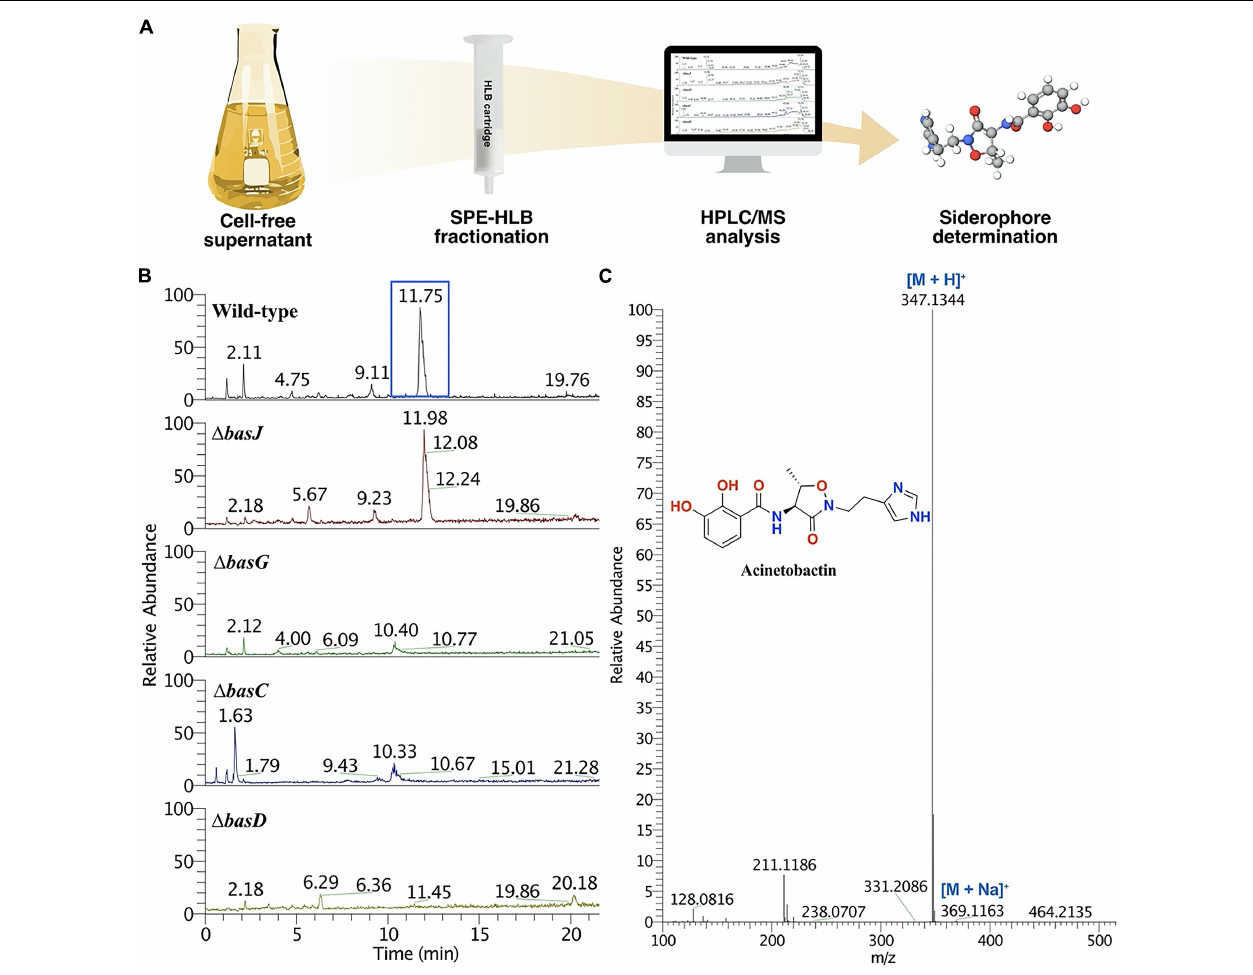
FIGURE 5 | (A) Schematic representation of the siderophore-content isolation SPE-HLB/HPLC-MS methodology carried out in the cell-free supernatant of A. baumannii wild-type and mutant strains. (B) Comparison of the total ion current (TIC) chromatographic profiles of the ABLH3 fraction of A. baumannii wild type, in which acinetobactin was detected at rt = 11.75 min, to that of five mutant strains with depleted genes involved in the biosynthesis of acinetobactin. (C) High resolution mass spectrum of acinetobactin detected in the chromatographic peak at rt = 11.75 min of the ABLH3 fraction obtained from the A. baumannii wild-type